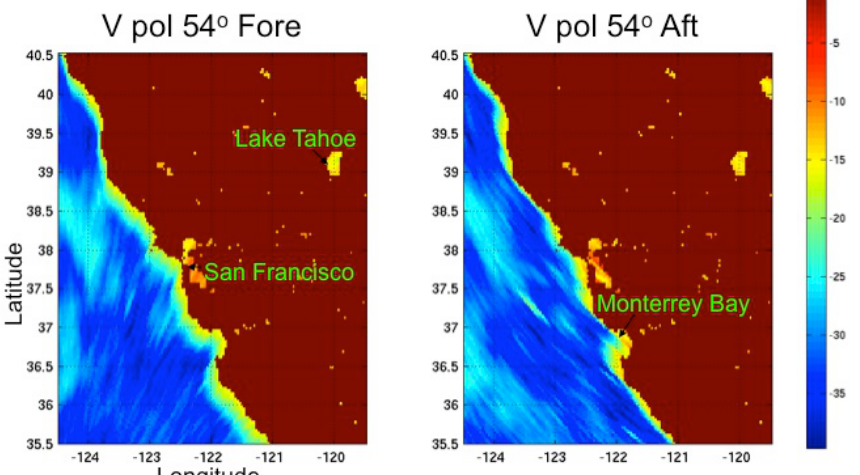
Figure 2: Land contamination in raw Normalized Radar Cross Section (NRCS) data for low wind (~ 5 m/s) conditions. Land contaminates NRCS and thus wind up to 30 km from the coast. How far from the coast it is contaminated depends upon the precise orientation of the measurements (range slices).